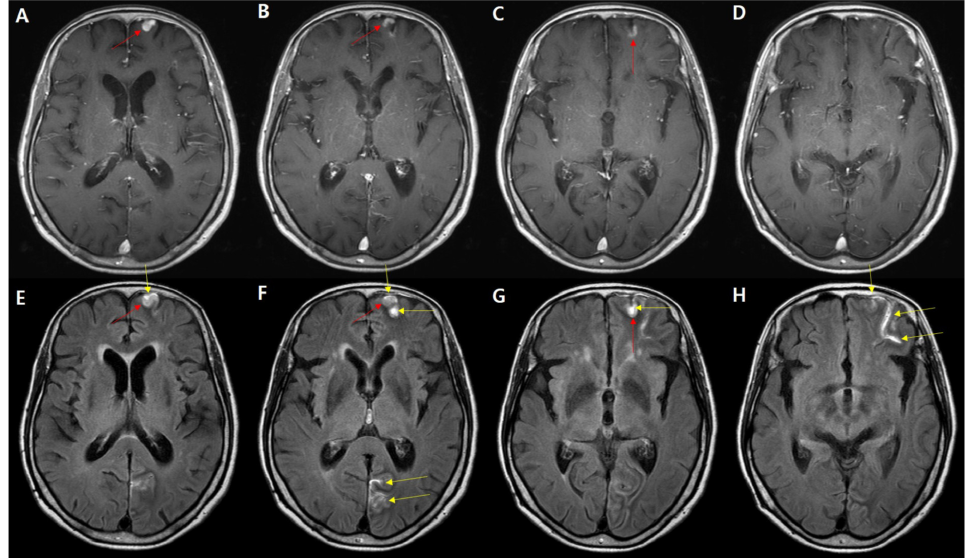
Figure 3. HARM related to a cortical enhancing lesion. A 76-year-old female presented with gait disturbance for 2 weeks. ( A – D ) Postcontrast T1WI showing nodular enhancement at the left anterior frontal cortex (red arrow). A postcontrast FLAIR image showing enhancement at the left frontal cortex and another linear, and stronger, enhancement along the left frontal sulci and left occipital sulci (yellow arrow, E – H ). Based on the HARM, this patient was treated with an antiplatelet and aspirin for 3 months, and her symptoms improved.